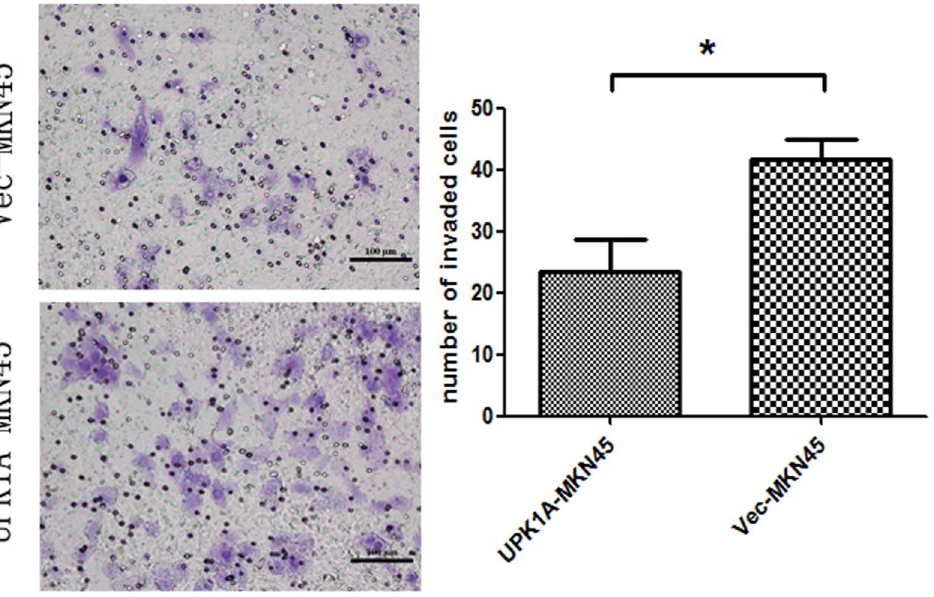
Figure 6. Matrigel invasion assays of vector-MNK45 and UPK1A-overexpressed MNK45 cells. The invading cells were fixed and stained with crystal violet (magnification, 200 6 ) on the left. The right images present the quantification of 10 randomly selected fields. The results represent the mean 6 SD of three independent experiments. *, P , 0.05.